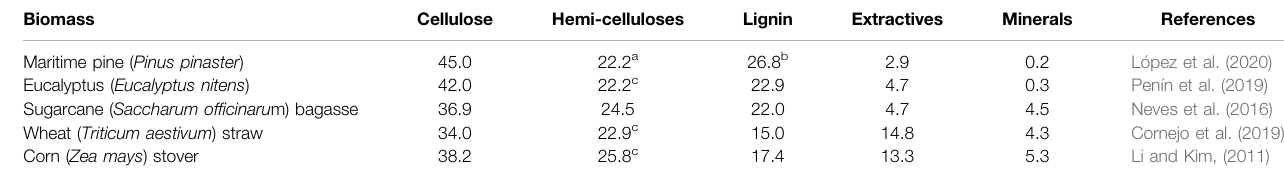
TABLE 1 | Summary of the composition of different types of lignocellulosic biomass (mass fraction in percent dry weight). Biomass Cellulose Hemi-celluloses Lignin Extractives